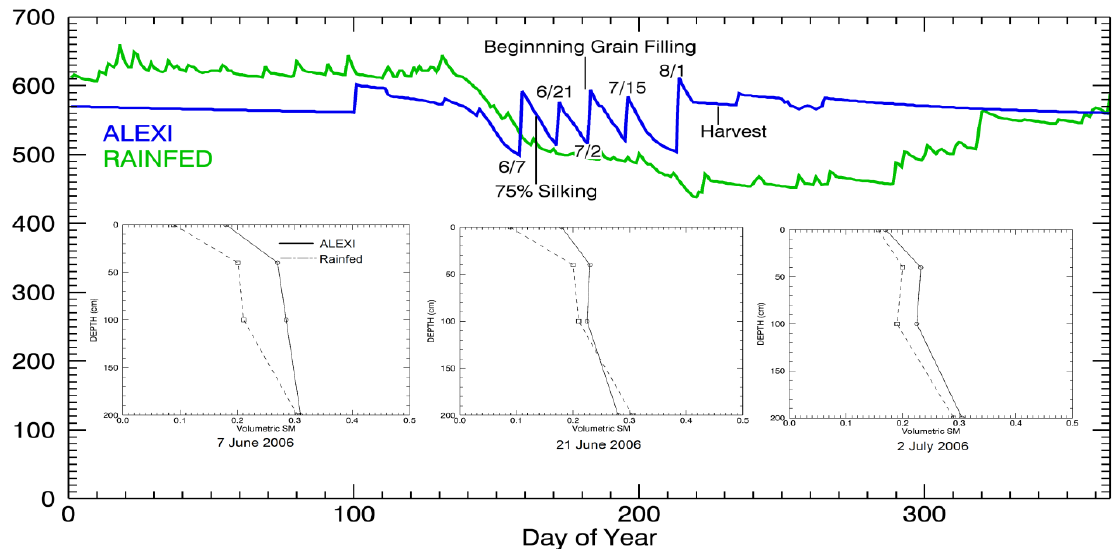
Figure 5. Comparison of DSSAT Rainfed and ALEXI forced soil moisture dynamics for the year